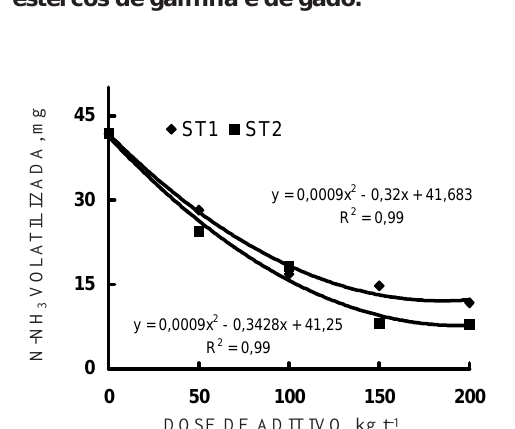
Figura 2. Efeito de doses de superfosfato simples com dois níveis de acidez residual (SS1 = 7,02% e SS2 = 2,36%) na volatilização de amônia, durante a compostagem de uma mistura de estercos de galinha e de gado.